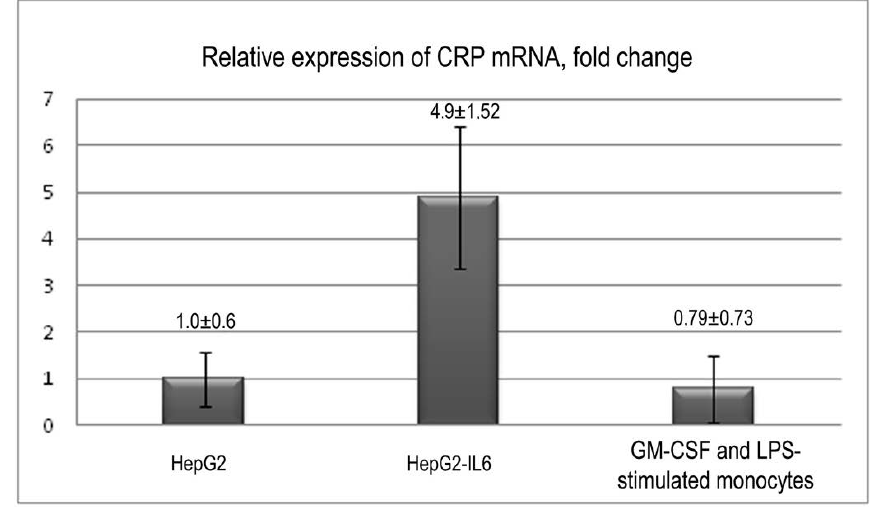
Figure 5. Real-time polymerase chain reaction (RT-PCR) results of the relative expression of CRP. CRP—C-reactive protein. HepG2—human cell line of hepatocellular carcinoma. HepG2-IL6—interleukin-6-stimulated HepG2 cells. GM-CSF, LPS-stimulated monocytes—granulocyte-macrophage colony-stimulating factor and lipopolysaccharide-stimulated peripheral blood monocytes. CRP expression was normalized against β -actin mRNA expression.